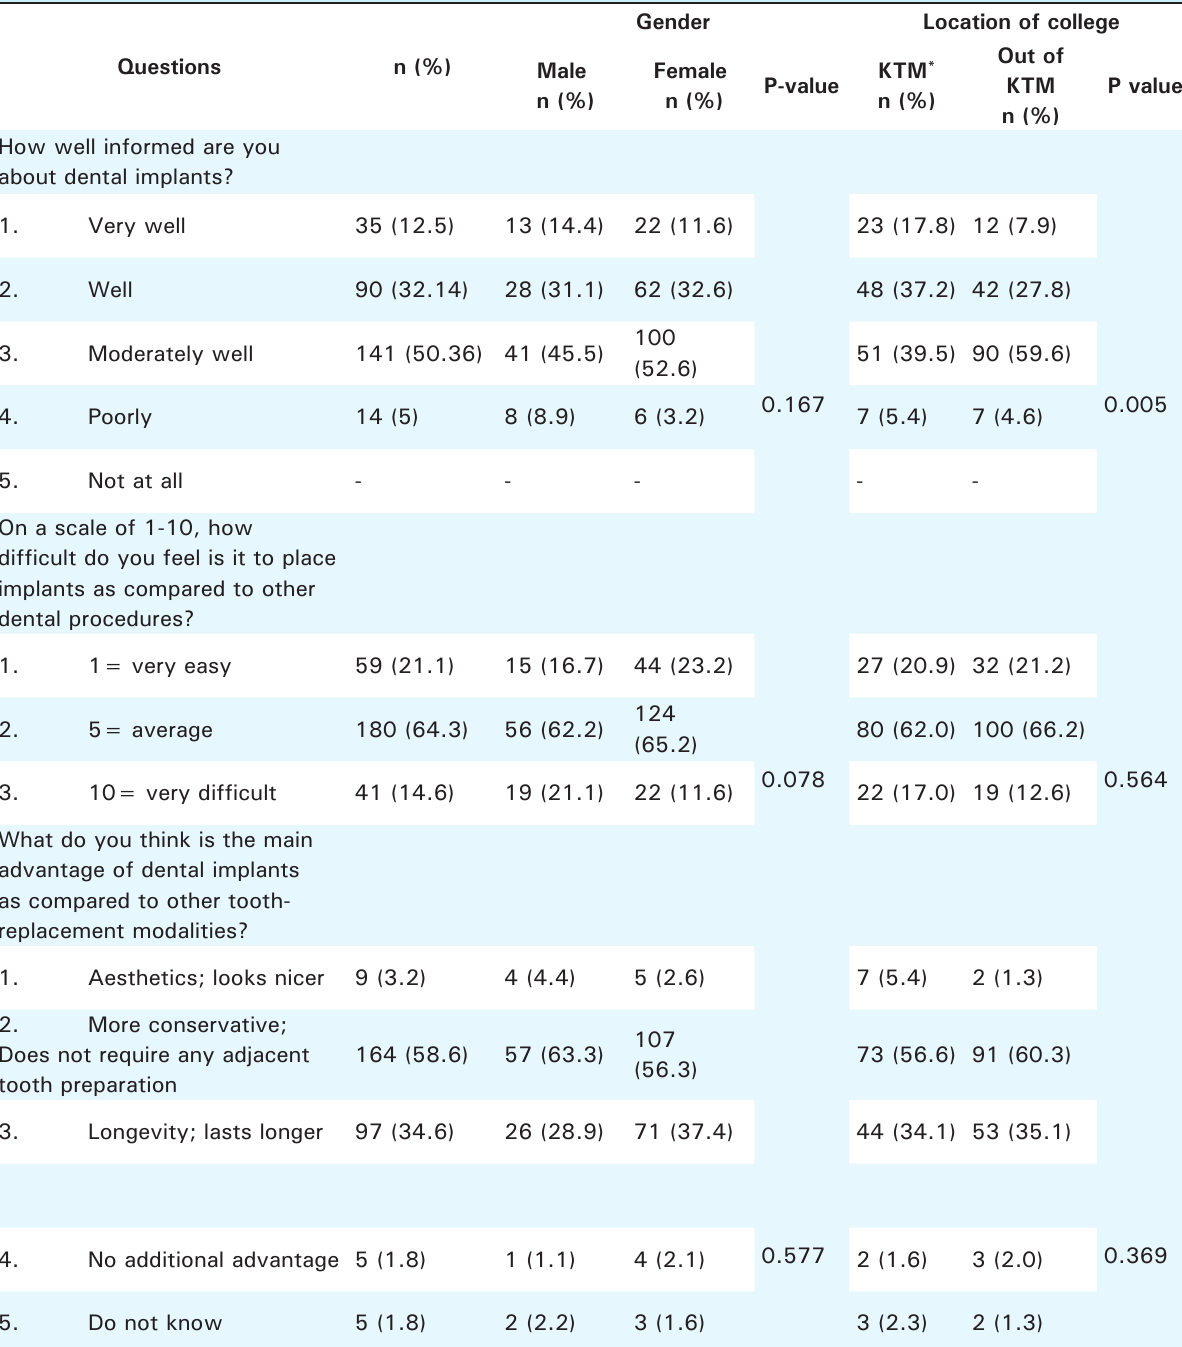
Table 1. Responses to the 1 st , 2 nd and 3 rd questions and their associations with gender and location of the